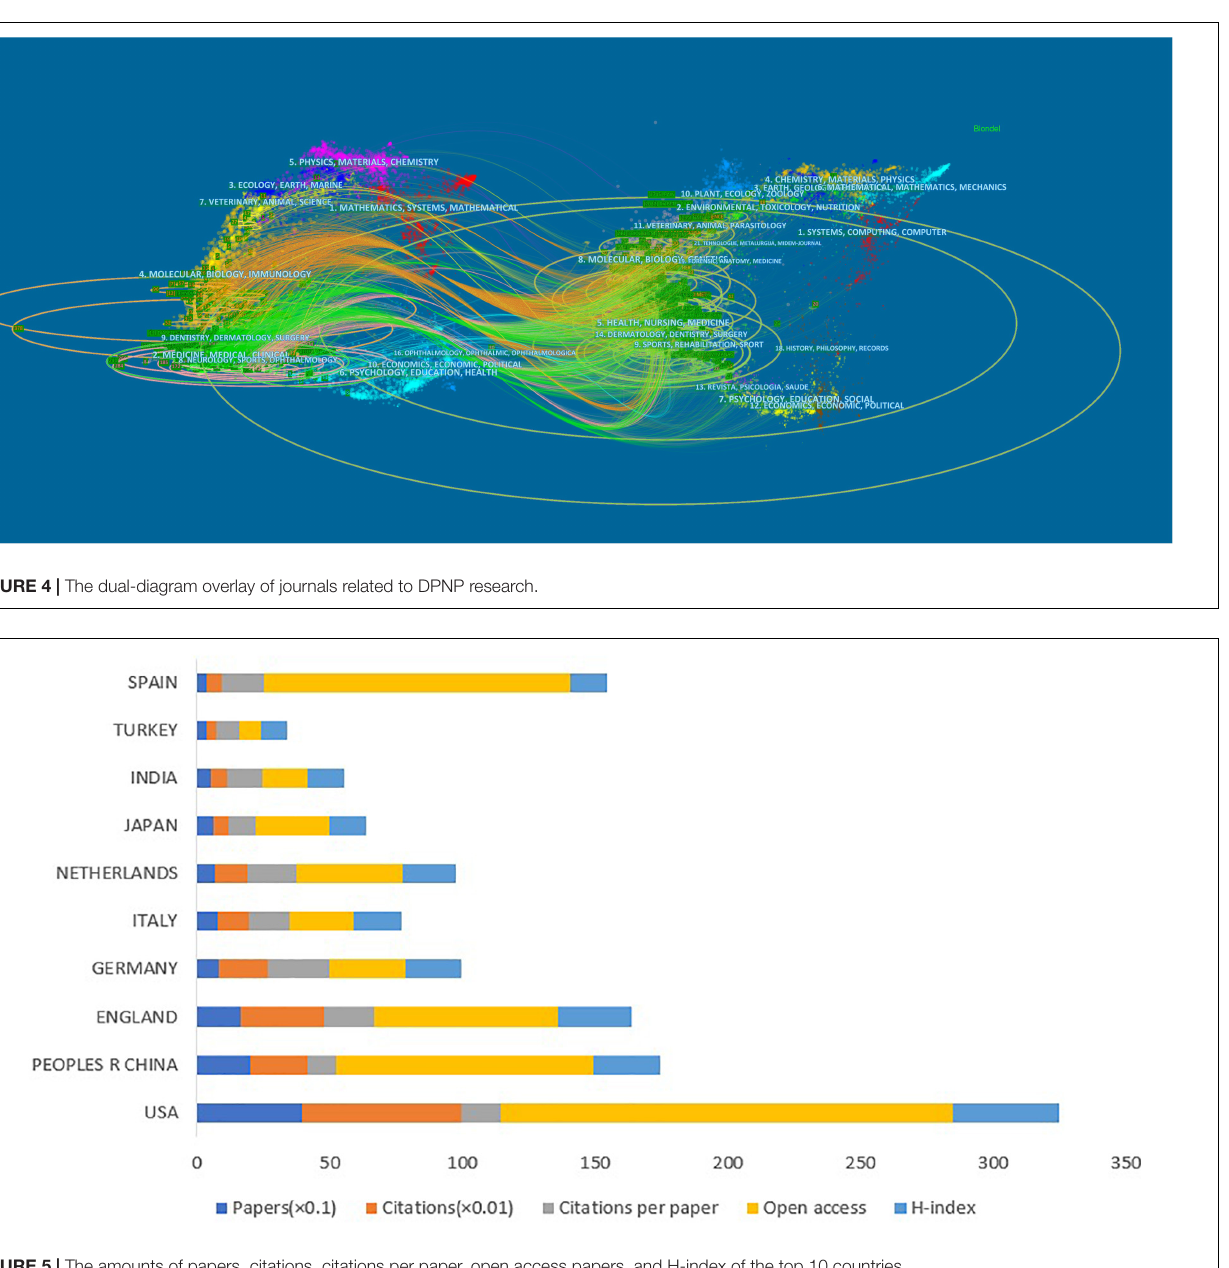
FIGURE 5 | The amounts of papers, citations, citations per paper, open access papers, and H-index of the top 10